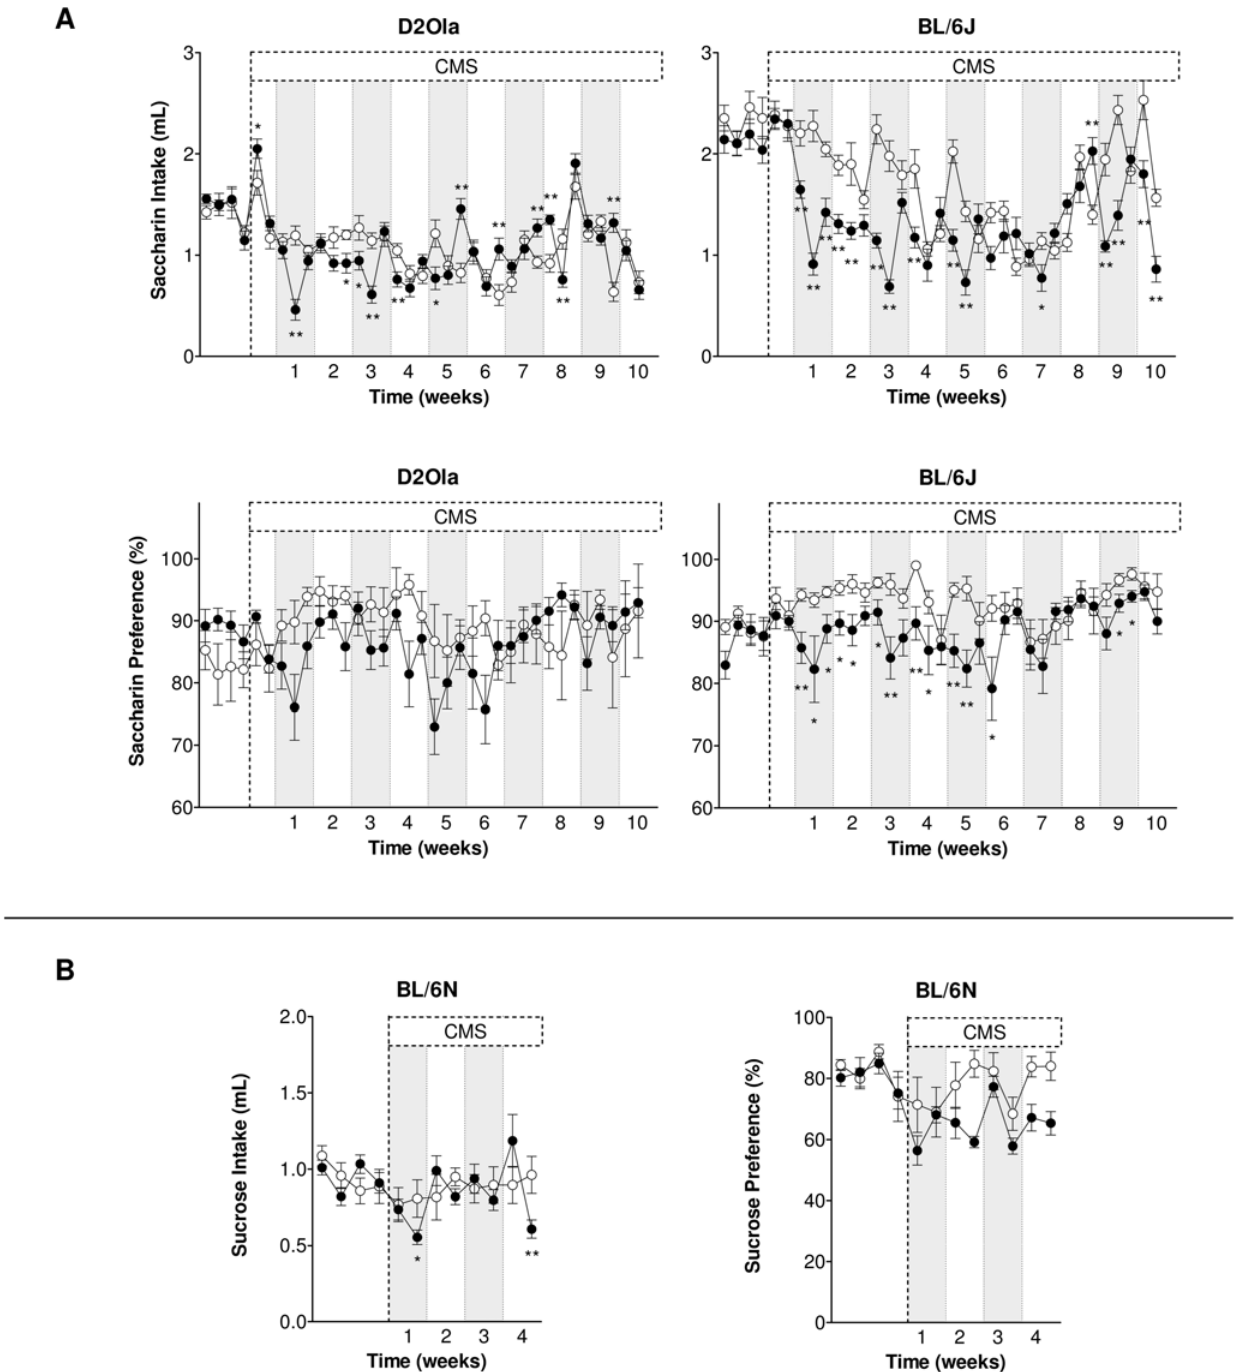
Figure 1. CMS effects on palatable liquid consumption per 2 hrs in D2Ola, BL/6J and BL/6N mice. (A) Effects of CMS on saccharin intake and preference over a period of 10 weeks in D2Ola and BL/6J mice (measurement 3x/week). (B) CMS effects on sucrose intake and preference over a period of 4 weeks in BL/6N mice (measurement 2x/week). Saccharin concentration: 0.2%, sucrose concentration 2%. White circles: control group, black circles: CMS group. First 4 data points of each graph represent basal consumption. Data represent mean 6 SEM, n=9–20/group. * p , 0.05, ** p , 0.01 pairwise between-group comparisons (Student’s t-test).